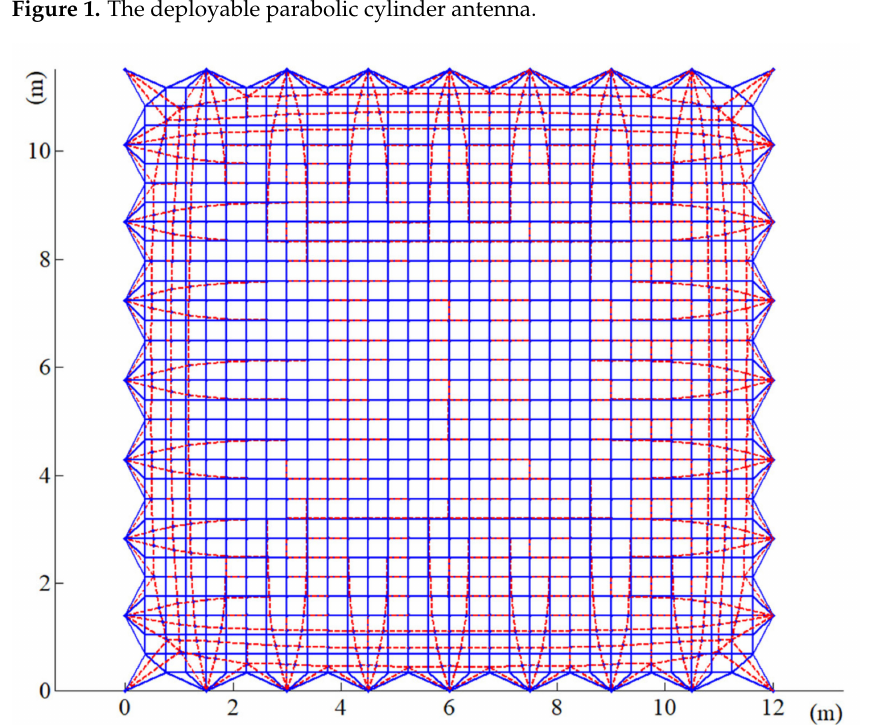
Figure 2. The result of form-finding analysis of mesh